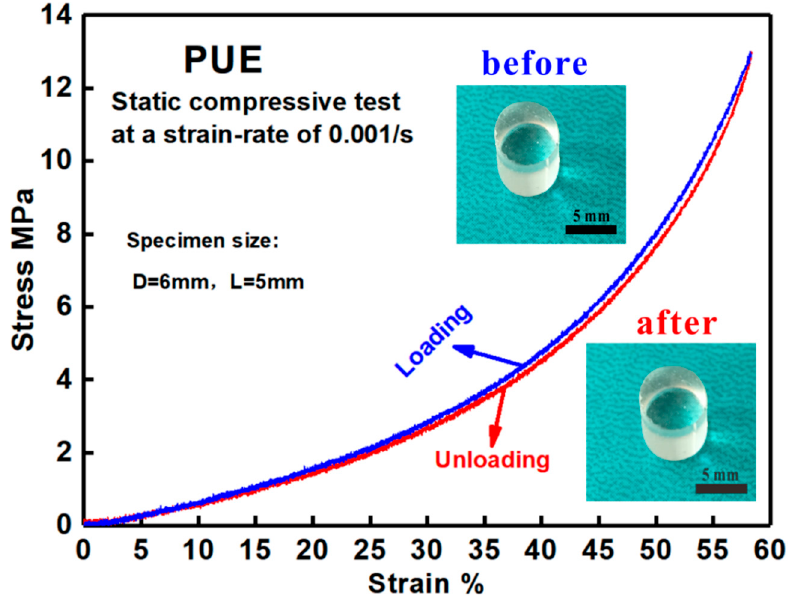
Figure 2. Quasi-static compressive stress–strain curves of the developed PUE material with a loading– unloading round and the fully recoverable deformation